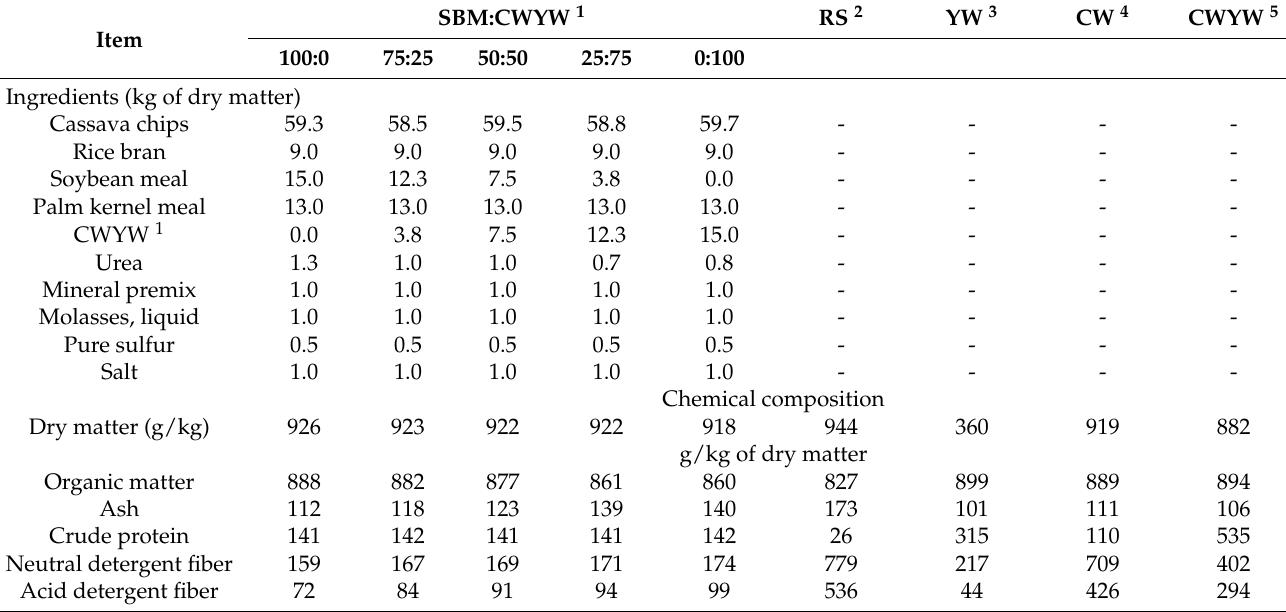
Table 1. Ingredient and chemical composition of concentrates, rice straw and citric waste fermented yeast waste used in the